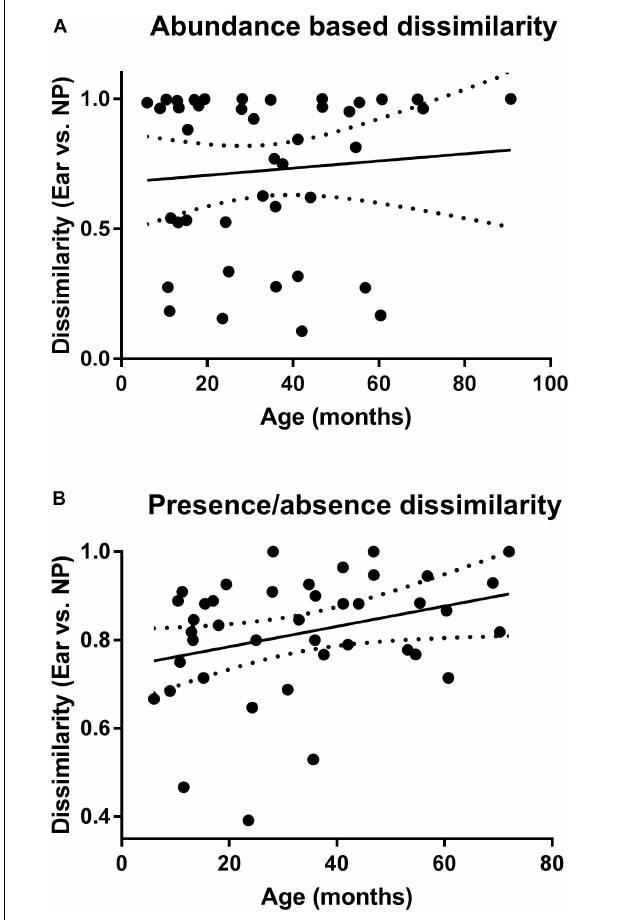
FIGURE 5 | Correlation of the microbiota of NP and MEF according to age. Shown are the abundance (A) and presence/absence (B) based dissimilarity values (for NP and MEF) for the children with AOM at different ages. Linear regression lines are indicated. P -value is significant for the presence/absence based dissimilarities ( P =